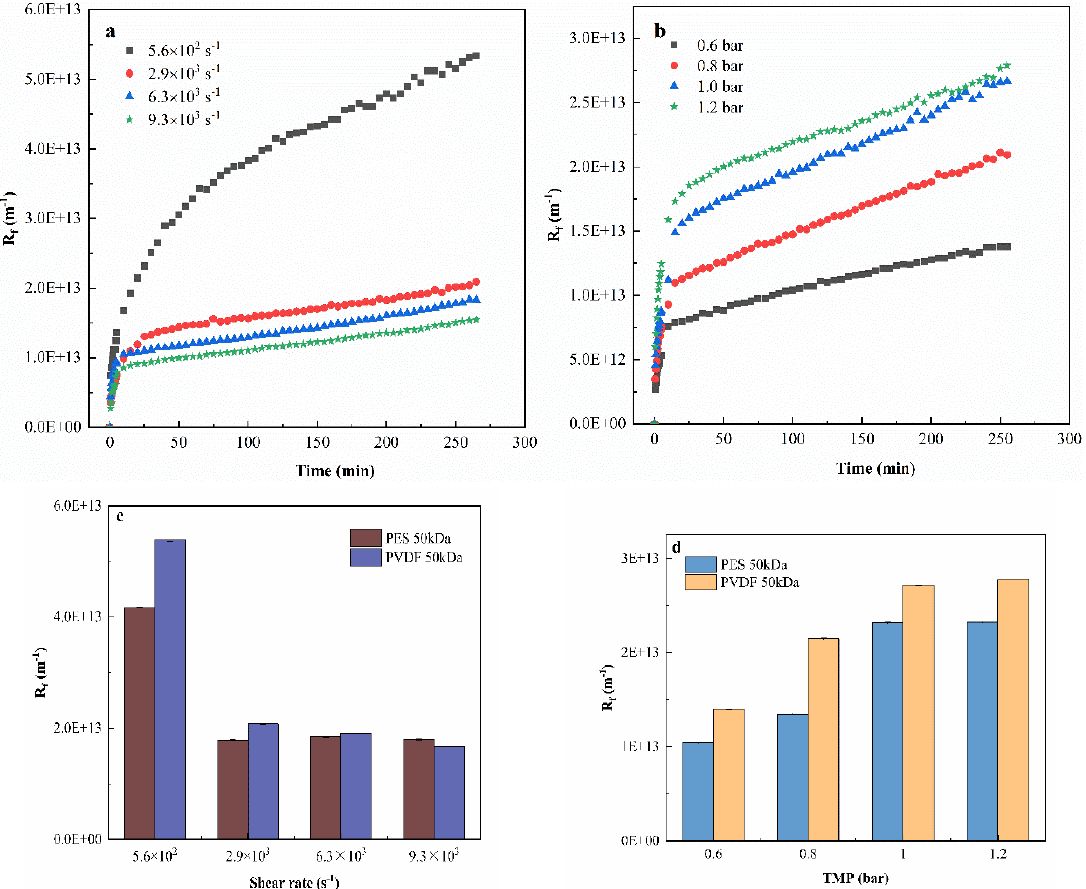
Figure 6. Effects of operating conditions on the process resistance ( R f ) in ultrafiltration of tanning wastewater: ( a ) R f evolution over time during UF at different shear rates (PVDF, TMP= 1.0 bar); ( b ) R f evolution over time during UF at different TMP (PVDF, shear rate = 2.9 × 10 3 s − 1 ); ( c ) the steady-state R f for different membrane materials at different shear rates (TMP = 1.0 bar); ( d ) the steady-state R f for different membrane materials at different TMP (shear rate = 2.9 × 10 3 s − 1 ).